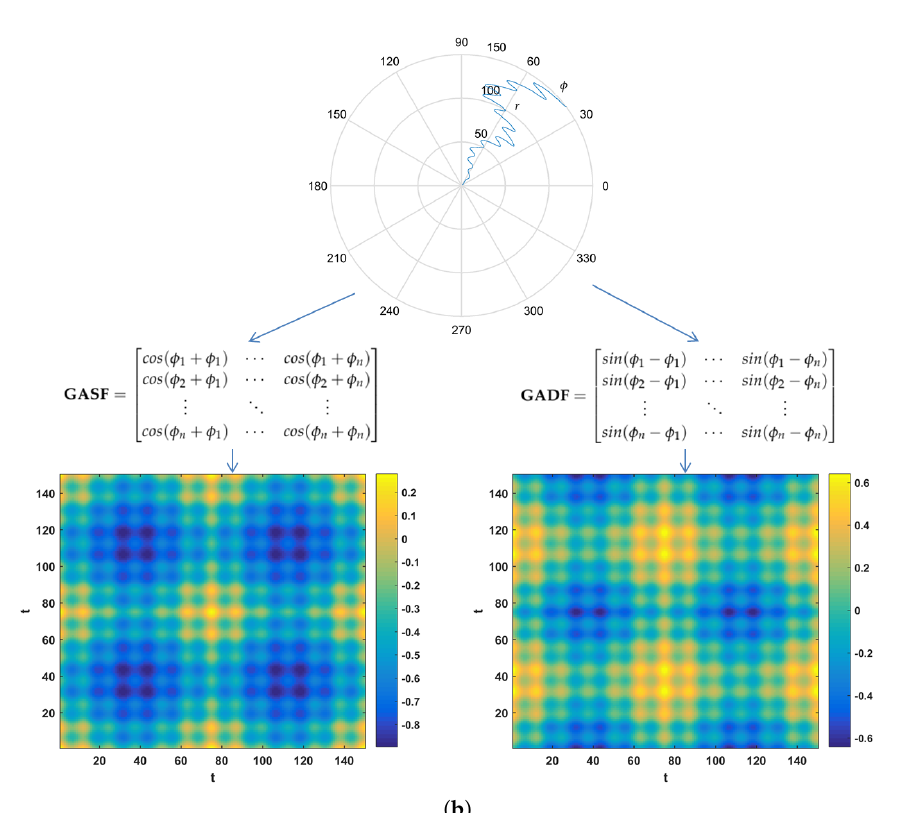
Figure 2. ( a ) Example time series signal; ( b ) polar coordinates mapping of the signal, Gramian Angular Summation Field (GASF), and Gramian Angular Difference Field (GADF) matrix transformation of the signal and their respective image